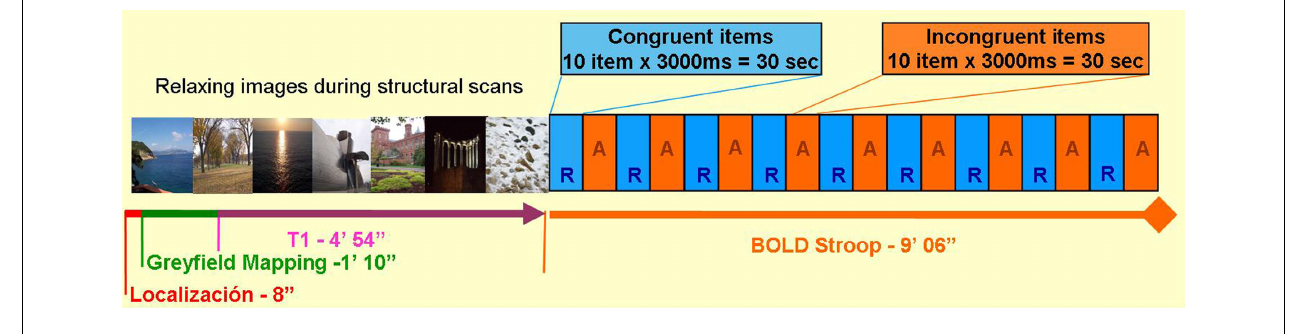
FIGURE 1 | Scheme of the scan sequences. During the first three sequences (anatomical sequences) relaxing images were projected. After that, the functional sequence was presented alternatively in